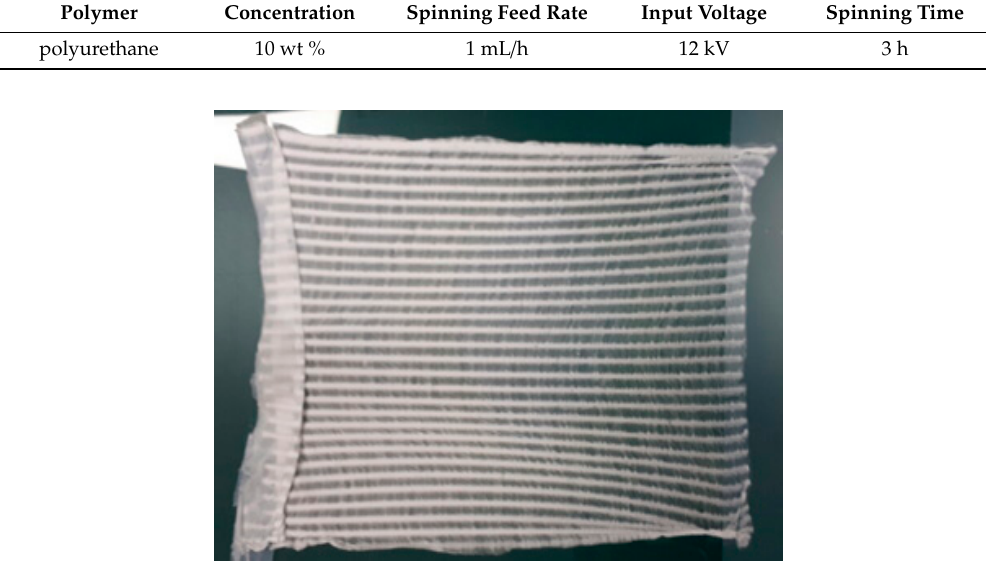
Figure 11. The photograph of a fabricated nanofiber mat.